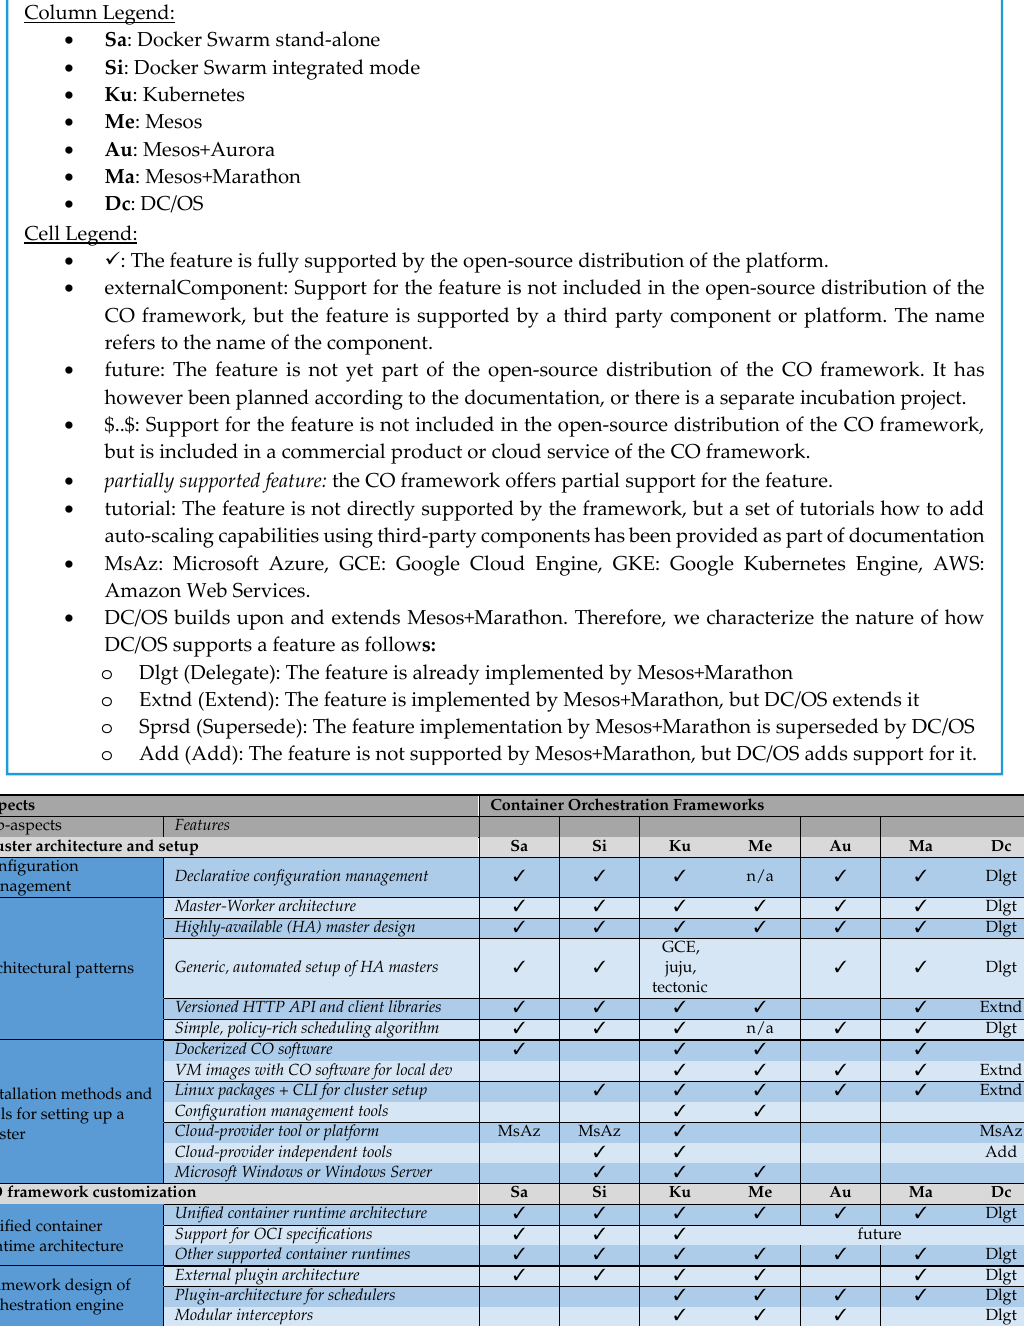
Table 2. Overview of the 124 common features and the mapping from features to CO frameworks.